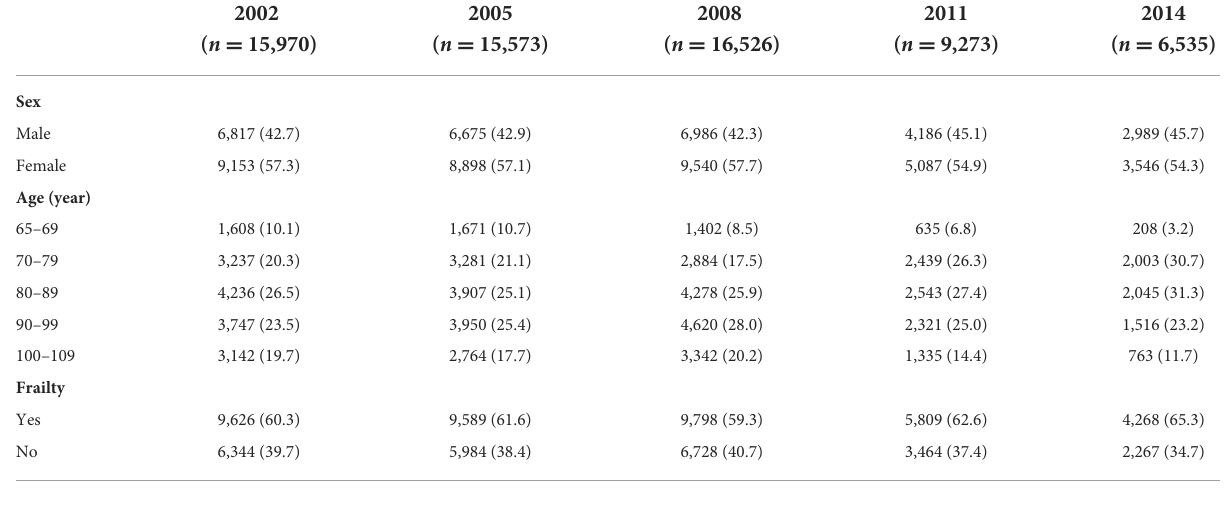
TABLE 1 Basic characteristics of the sample.